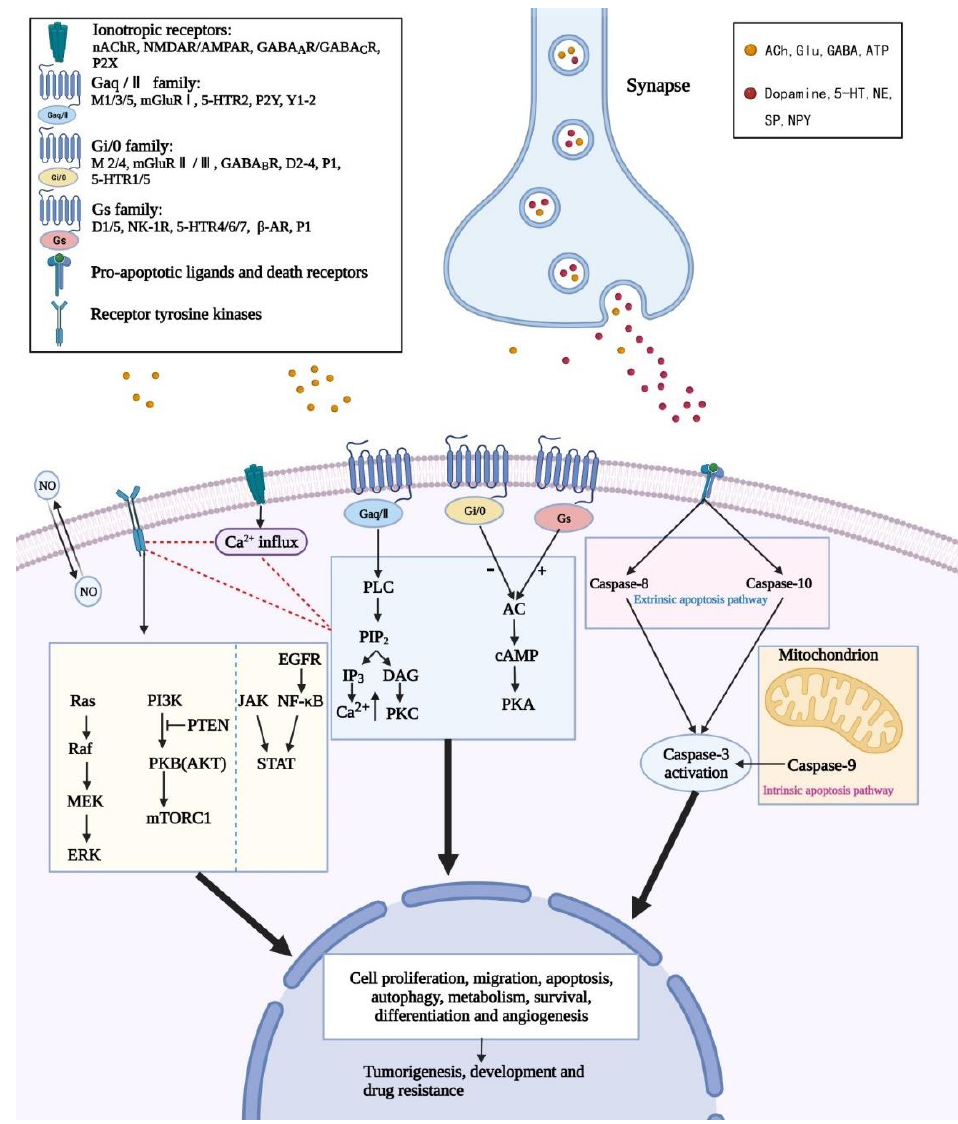
Figure 1. The modulation of neurotransmitters on common molecular pathways. Neurotransmitters mediate the transformation of extracellular ligand signaling into intracellular signaling through multiple kinds of receptors, thus, affecting cell proliferation, migration, metabolism, apoptosis, au- tophagy, survival, differentiation and angiogenesis. The main intracellular signaling includes RTK pathways, GPCR pathways, apoptosis and autophagy signaling pathways. The activation of RTKs and GPCRs are associated with Ca 2+ flux, which has been considered as the initial impulse and crit- ical modulator of GBM signaling. All neurotransmitters can be identified by GPCRs, while ACh, Glu, GABA and ATP secretion activate Ca 2+ flux via ionotropic receptors. GPCR mainly consists of three families: (i) Gaq/11 family (including M1/3/5 mAChR, mGluR I, 5−HTR2, P2Y and Y1/2), (ii) Gi/o family (including M2/4 mAChR, mGluR II/III, GABABR, D2−4, P1 and 5−HTR1/5) and (iii) Gs family (including D1/5, NK−1R, 5−HTR4/6/7, β −AR and P1). The mTOR pathway plays a vital role in autophagy induction. NF−kB has been shown to get involved in tumorigenesis, tumor growth